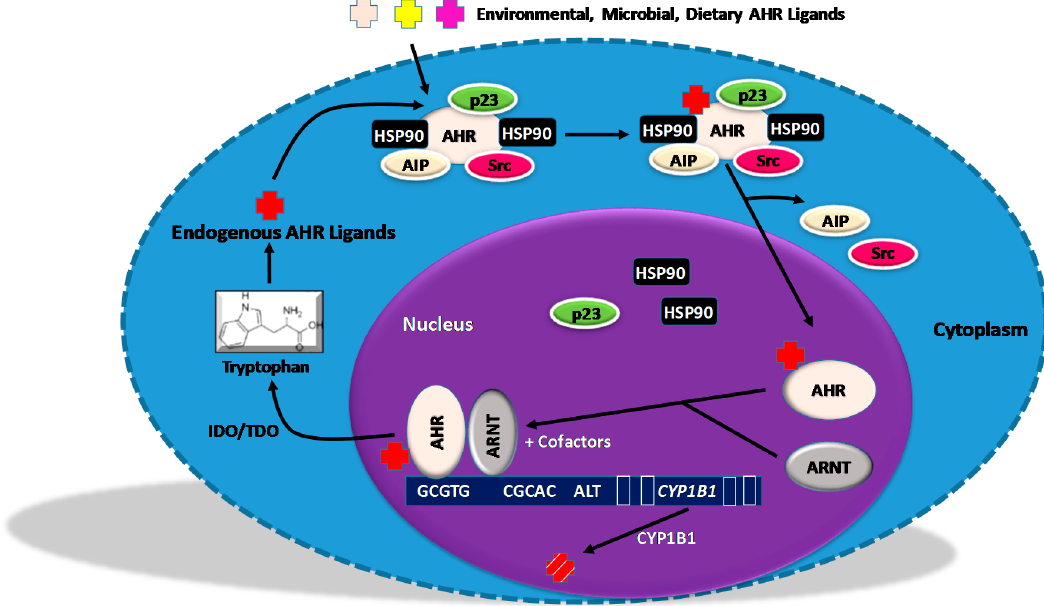
Figure 1. The Transcriptional AHR Signaling Pathway. Cytoplasmic aryl hydrocarbon receptor (AHR) exists in a complex with HSP90, Immunophilin-like Ah Receptor-interacting Protein (AIP), p23, and Src 40. Once engaged with exogenous or endogenous ligands, the AHR sheds AIP and Src and translocates to the nucleus. In the nucleus the AHR dimerizes with the Aryl Hydrocarbon Nuclear Translocator (ARNT), binds to consensus Aryl Hydrocarbon Response Elements (AHREs), recruits coactivators, and transactivates a battery of genes including the hydroxylases CYP1B1 and CYP1A1 , which metabolize some environmental AHR ligands into mutagenic epoxide intermediates. (Alternative AHR complexes containing NF- κ B subunits, KLF6, or potentially other proteins bind to hybrid (AHRE/NF κ B sites) or alternative DNA sequences to activate different sets of AHR responsive genes). CYP1B1 degrades at least some endogenous and exogenous AHR ligands in a negative feedback loop. The AHR complex can also induce IDO1/2 and/or TDO dioxygenases, which metabolize tryptophan into endogenous AHR ligands including, but not limited to, Kyn (kynurenine), in a positive feedback loop (see Section 5). Distinct sets of genes are activated by different AHR ligands, likely a result of differential co-factor recruitment. The AHR also functions through non-transcriptional pathways not represented here.